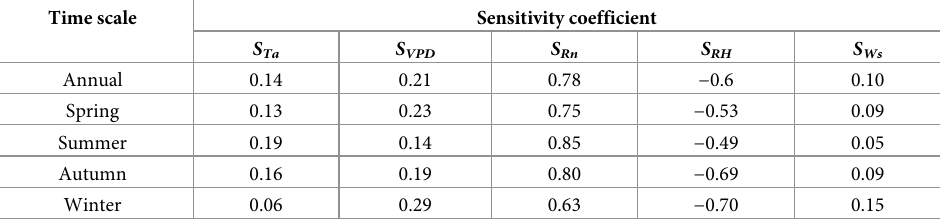
Table 4. The sensitivity coefficient of the potential evapotranspiration to the five basic meteorological variables. Time